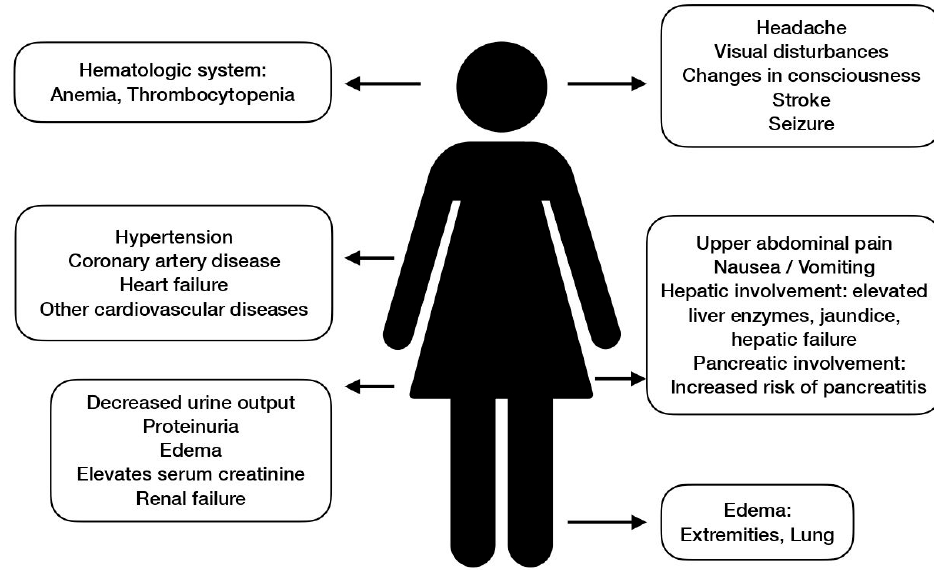
Figure 4. Systemic manifestations of preeclampsia.